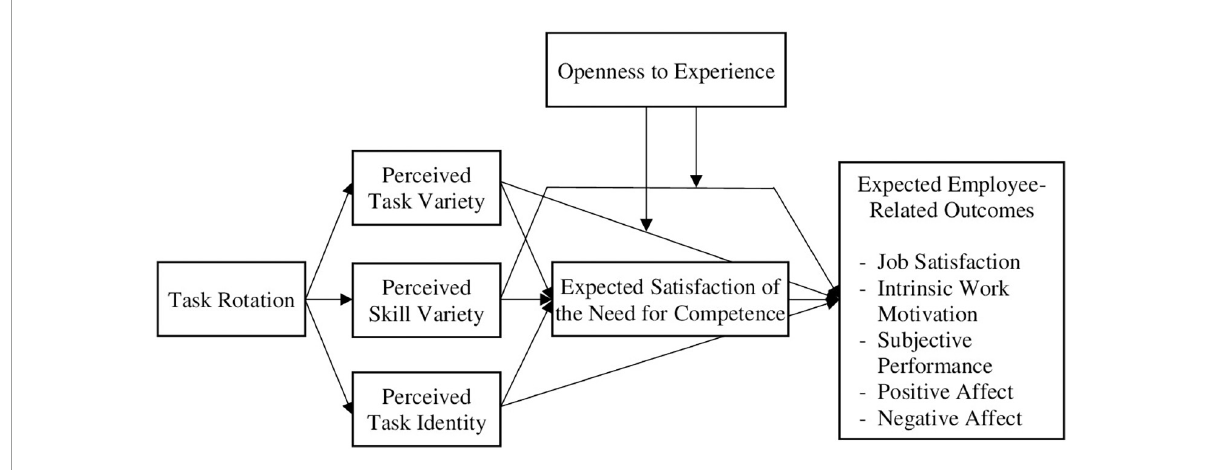
FIGURE1 Openness to experience was only investigated in Study